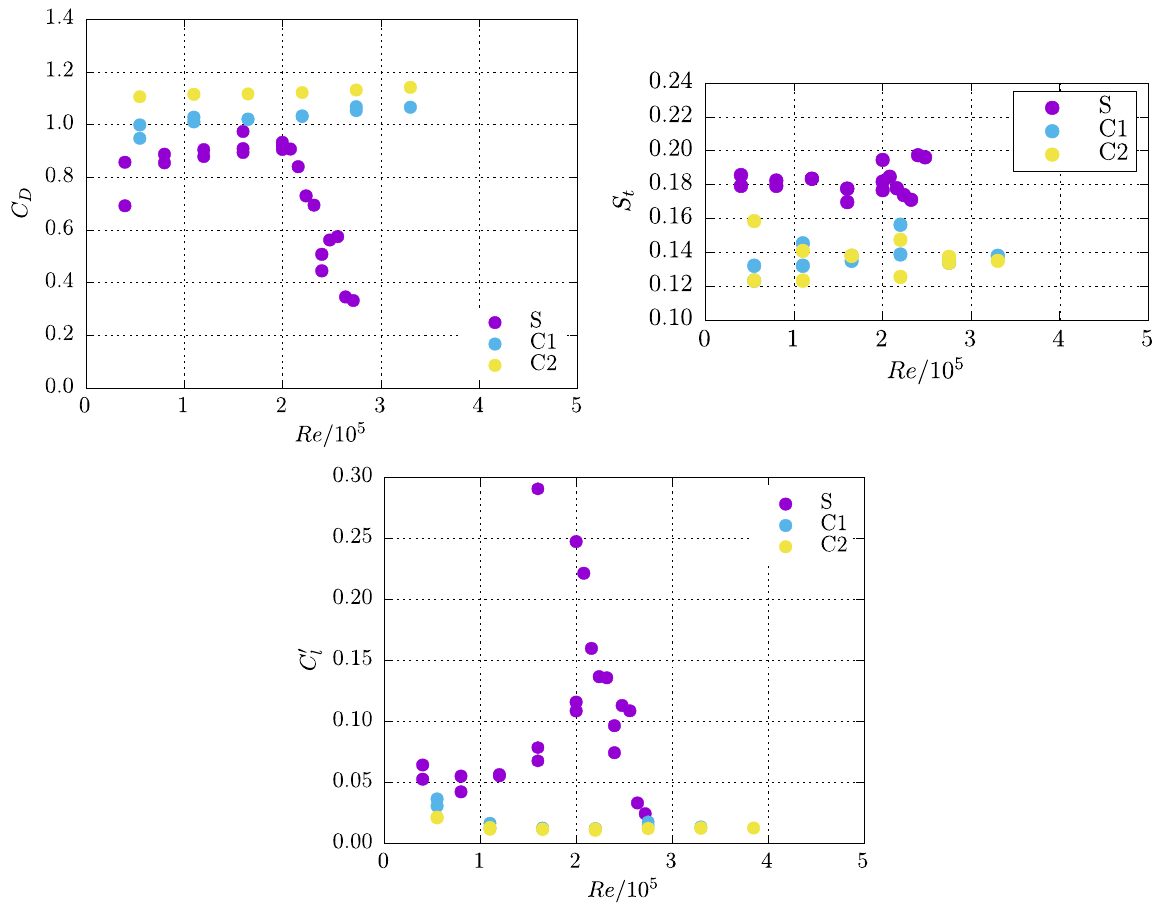
Figure 9. Distribution of the three main hydrodynamic parameters as function of the Reynolds number from direct force measurements for the three test cases: S , C1 and C2 .